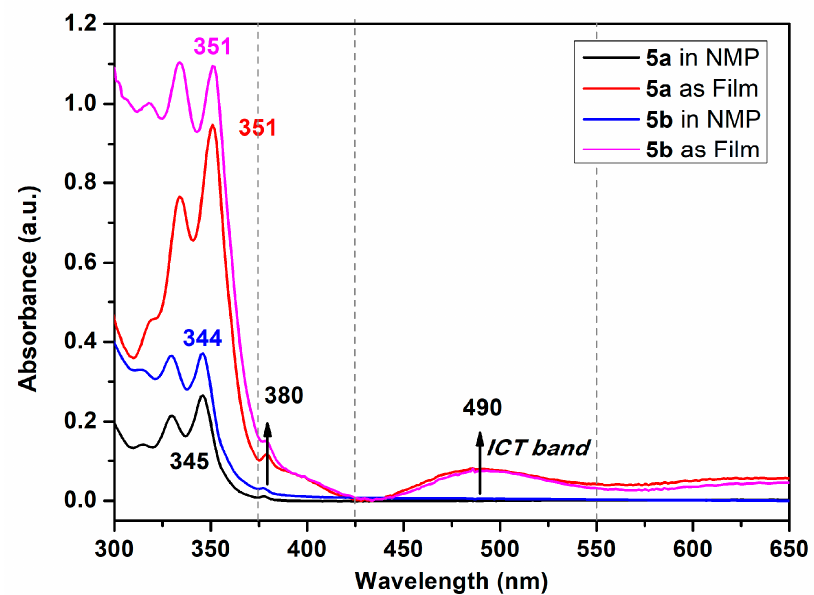
Figure 7. Absorption spectra of polyamides 5a and 5b in NMP solution (10 μ M) and solid films coated on quartz glass.